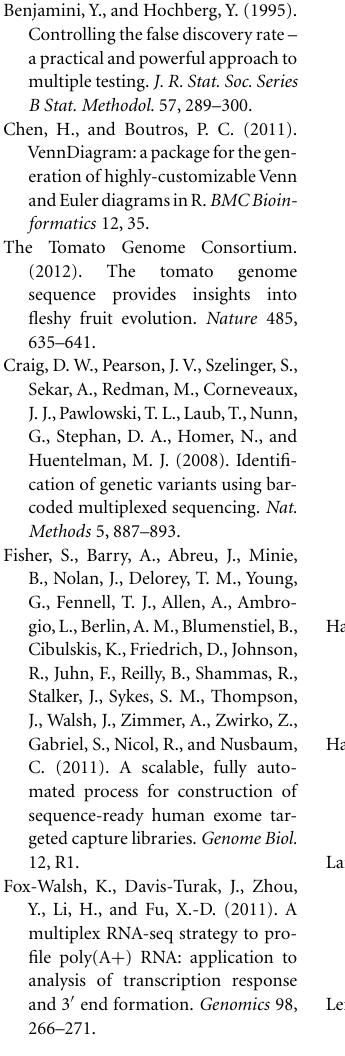
Figure S5 | Distribution of gene expression levels. Figure S6 | DE based on higher cutoffs. Figure S7 | Count distribution by gene length in C1 and C2 methods.